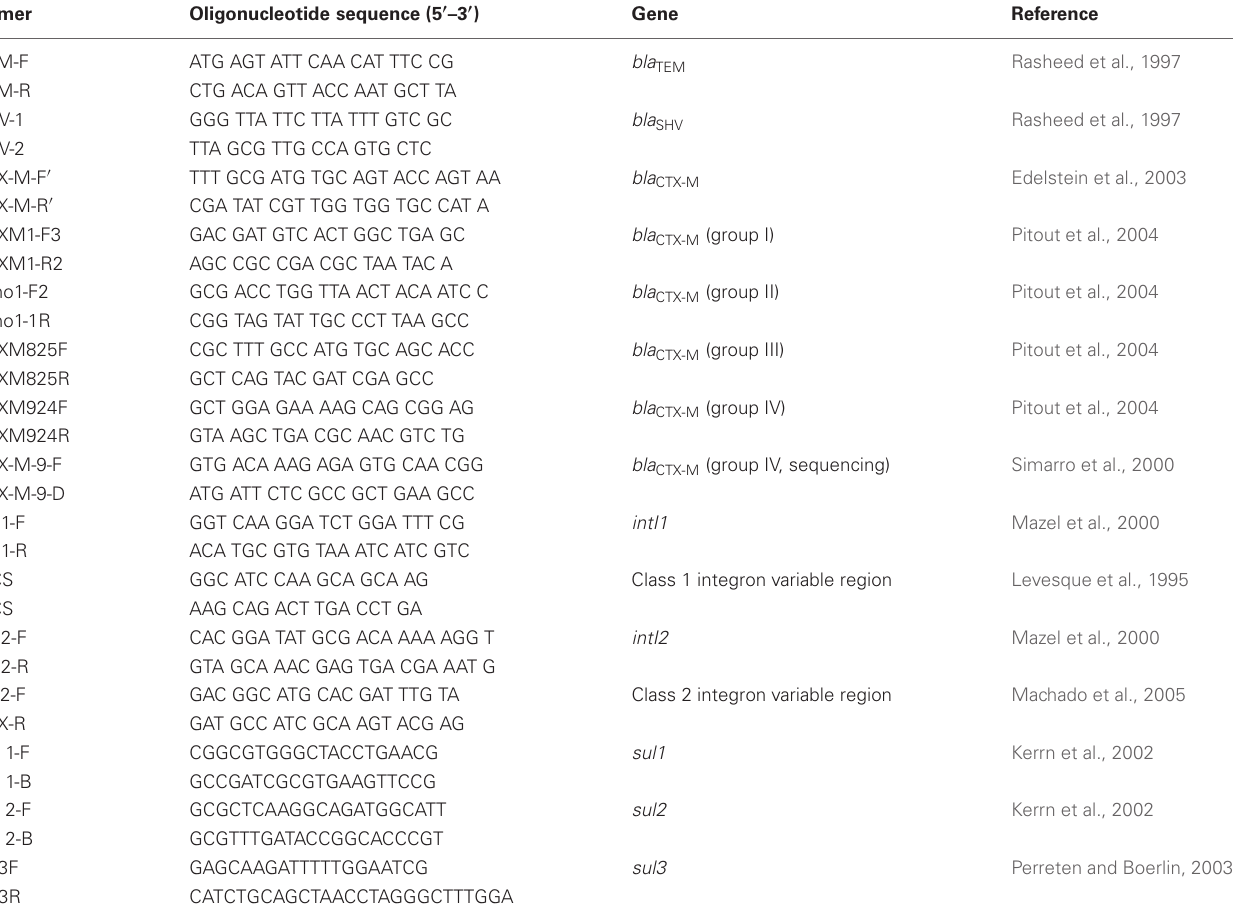
Table 1 | Primers used in this study.